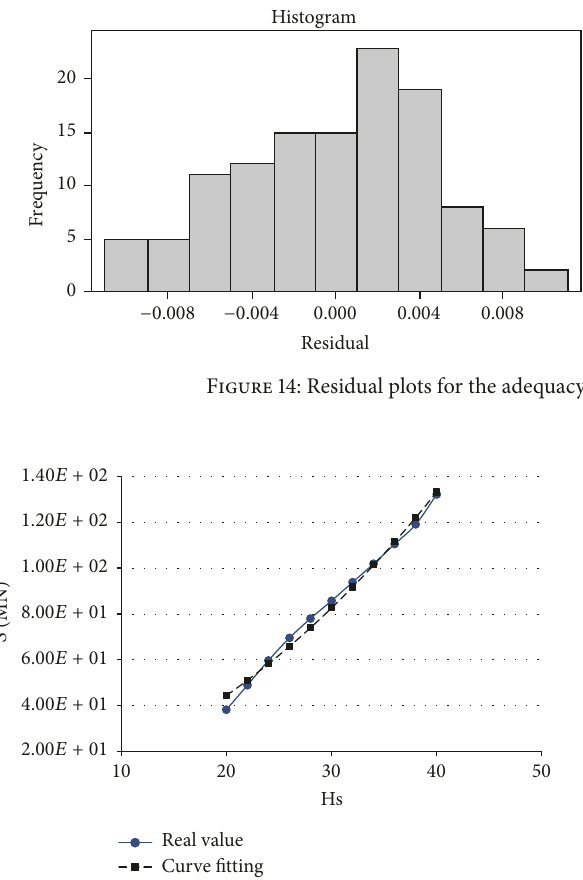
Figure 15: Comparison between the calculated base shear and the curve